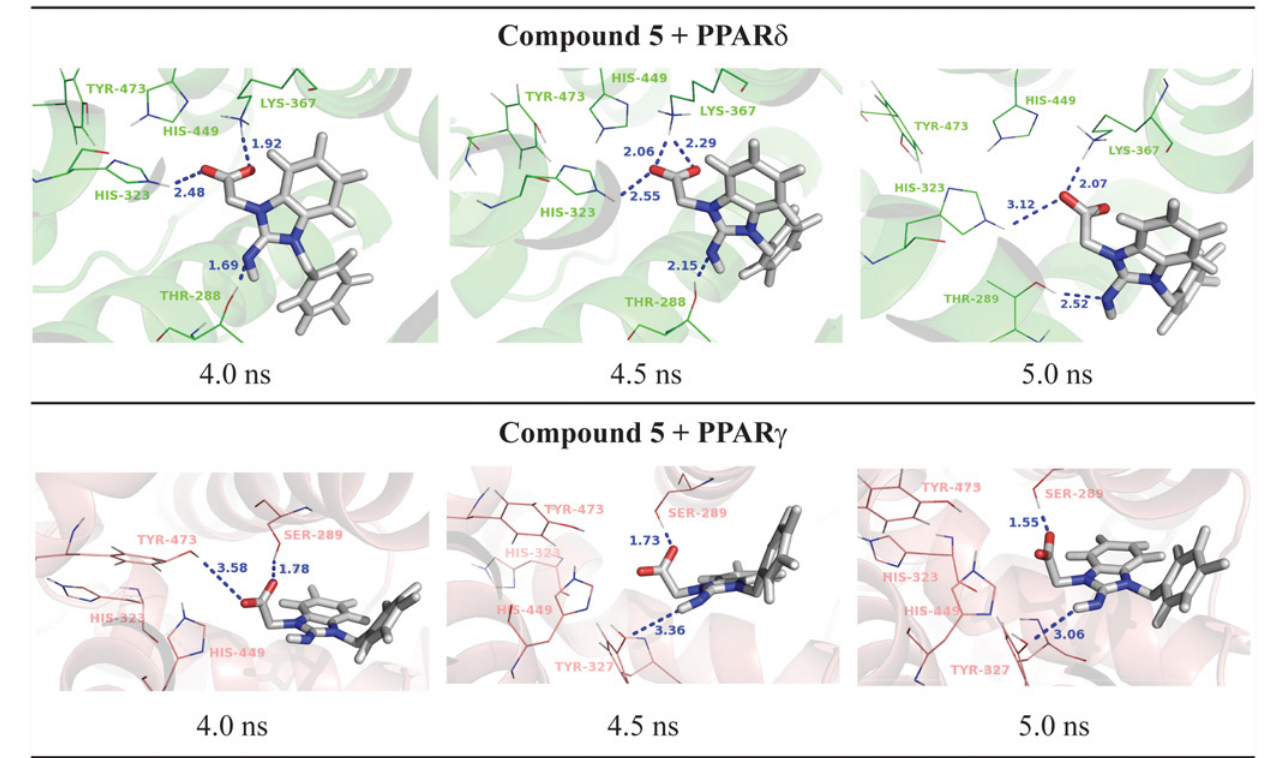
Fig 6. Final nanosecond snapshots of compound 5 molecular dynamic simulations in complex with PPAR subtypes. Main polar interactions between the compound 5 and the PPAR δ and PPAR γ during the final nanosecond of MD